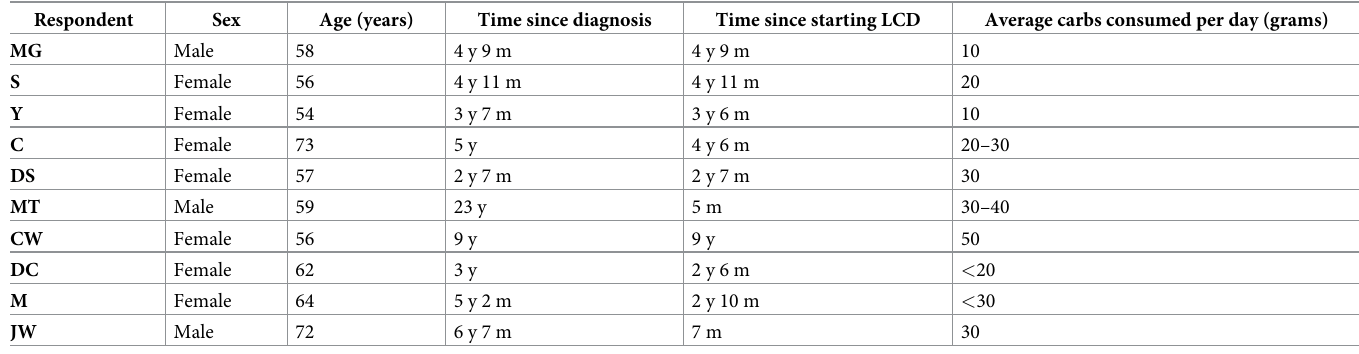
Table 1. Participant demographics.